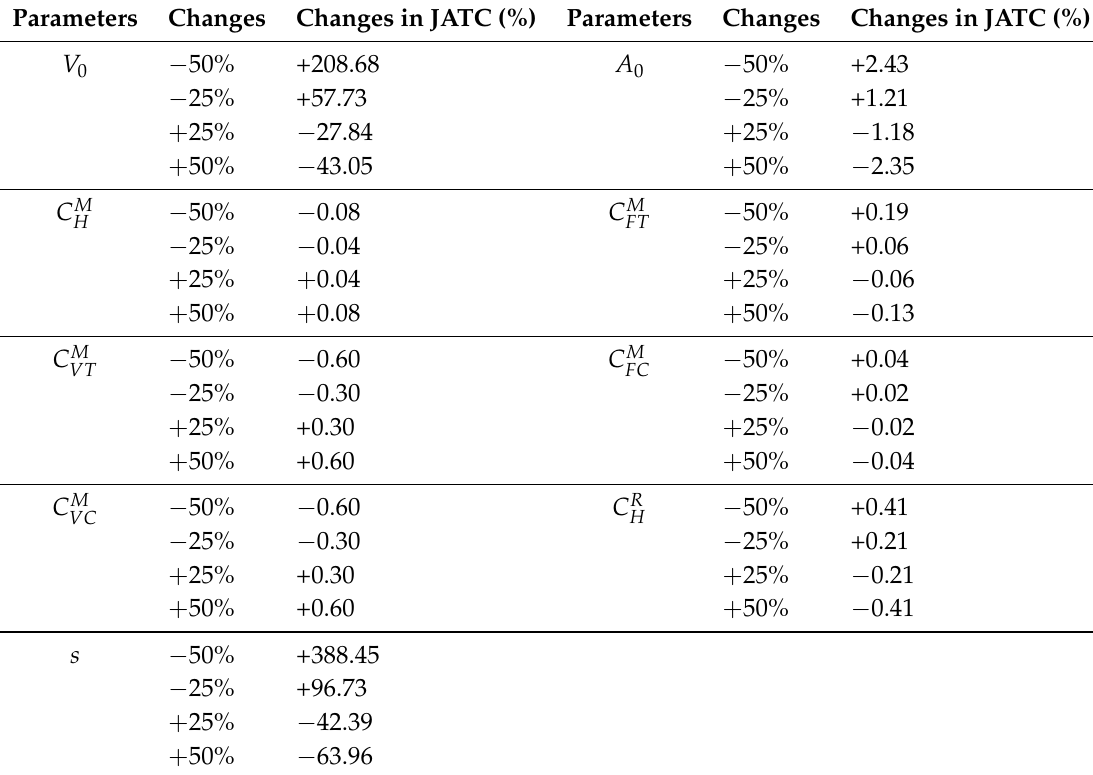
Table 4. Sensitivity